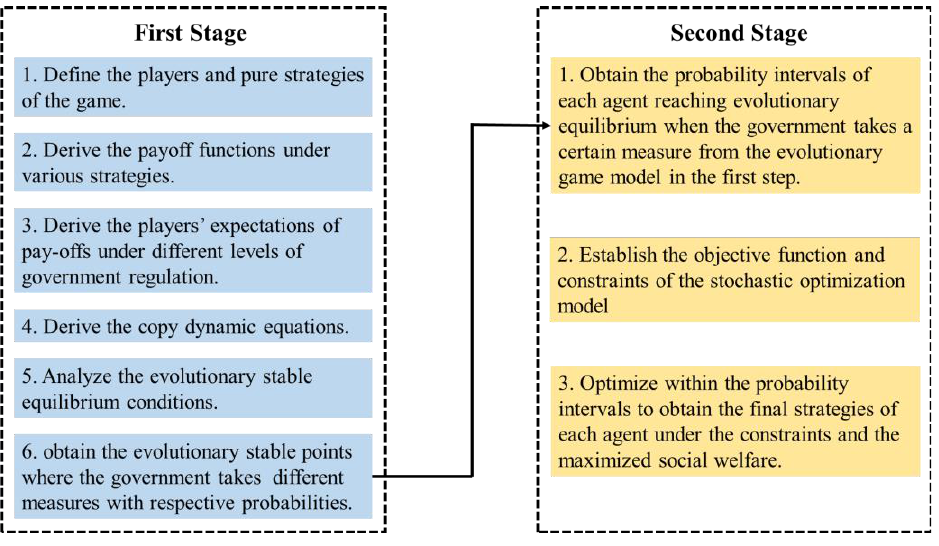
Figure 1. Framework of the two-stage model.